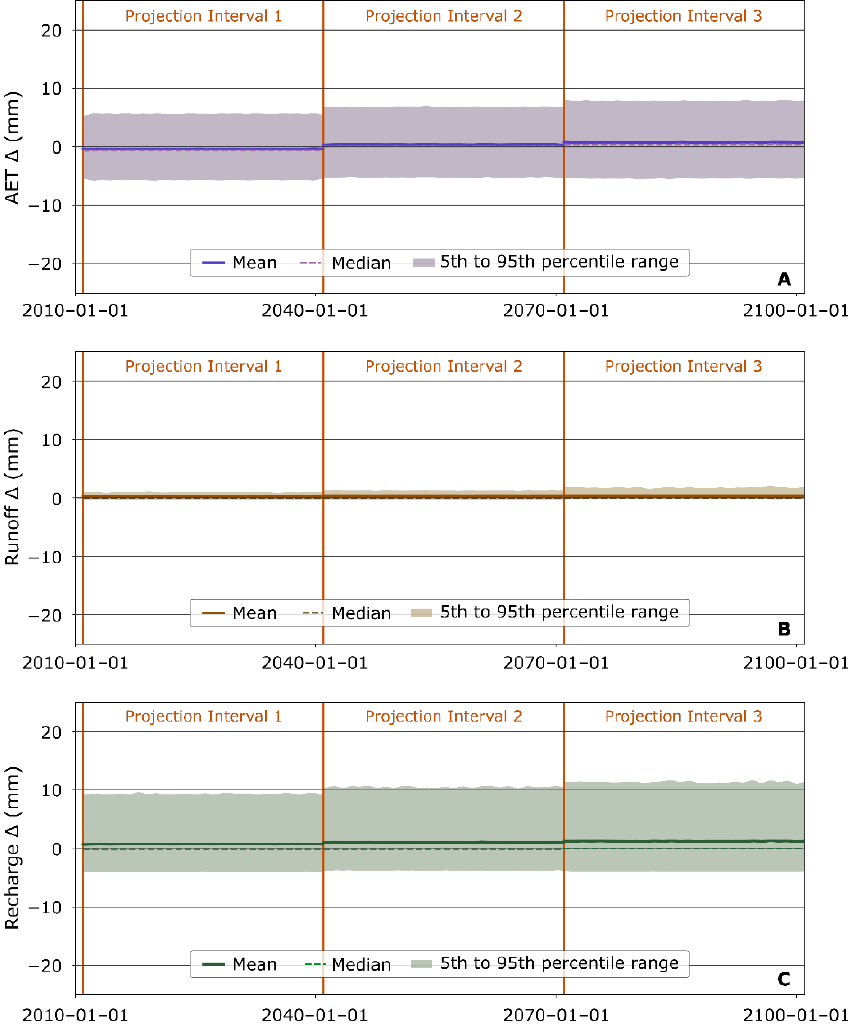
Figure 11. Monthly water balance modeling framework analysis Δ time histories. ( A ) AET is rela- tively unchanged for average conditions but maximum values increase due to increase in maximum precipitation values and corresponding increase in water availability. ( B ) Runoff displays minimal change on average but shows a slight positive bias for the 95th percentile. ( C ) Recharge shows a slight increasing trend on average and slight positive bias for the 5th to 95th percentile range due to simulation of larger magnitude extreme events in future conditions.